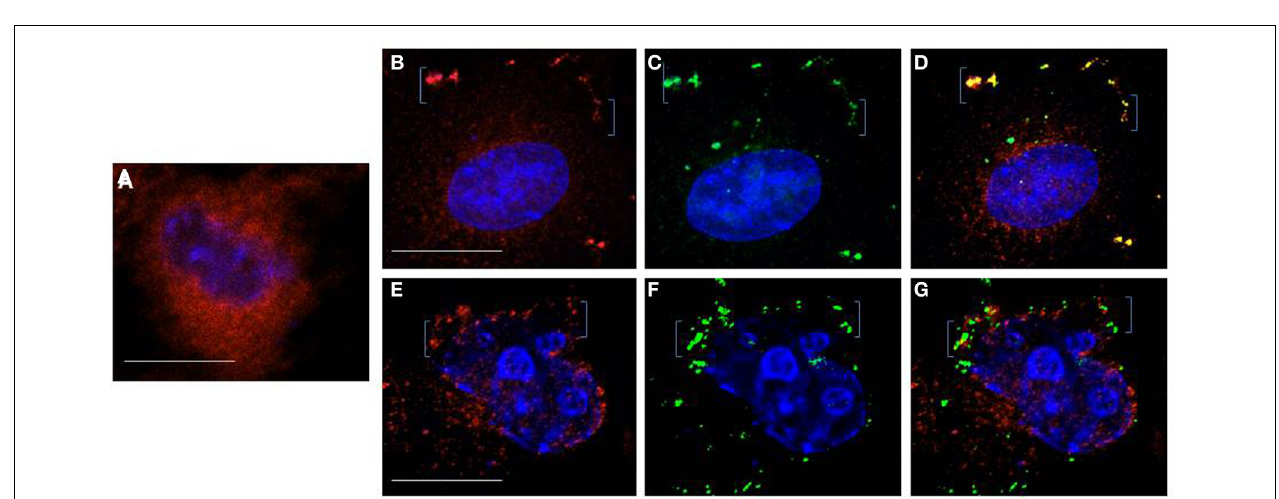
images with IP3R-tagged gold detected at or near the plasma membrane ( thin arrows ) and in budding or fully released VLPs ( thick arrows ). Bar: 100nm. (E) Distributionofgold-taggedIP3Rinmock-treatedcellsandcellsexpressingGag.